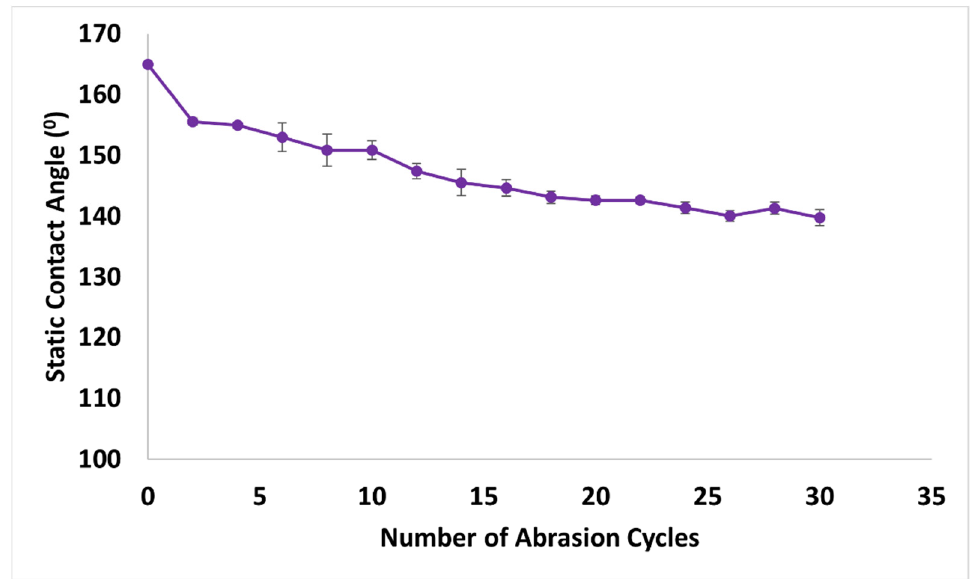
Figure 5. Static contact angles after Taber abrasion test against 29.9 kPa applied normal load .